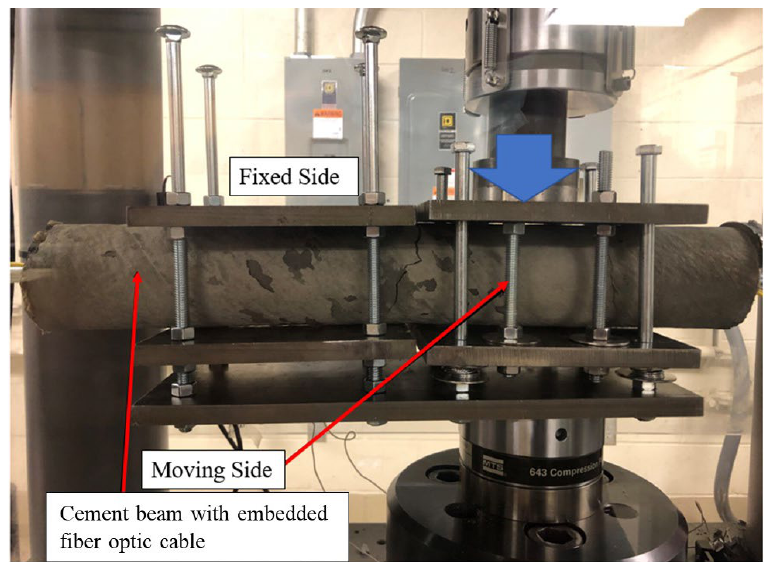
Figure 12. Schematic of the shear displacement fixture.